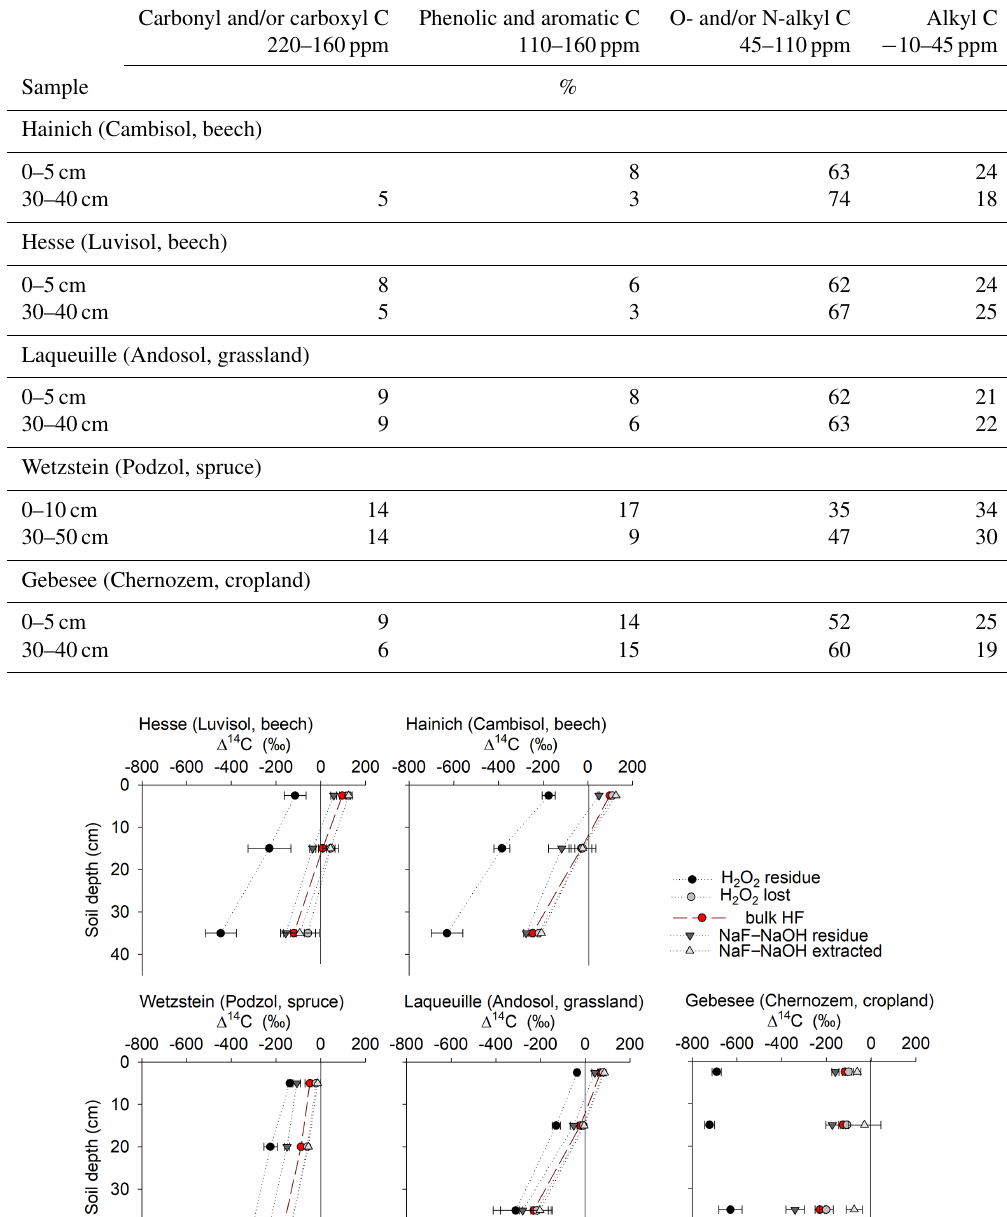
Table 1. Distribution of C species in organic matter extracted into NaF–NaOH from heavy fractions of mineral topsoil (0–5cm depth) and subsoil (30–40 or 30–50cm depth) layers as revealed by CPMAS- 13 C-NMR.